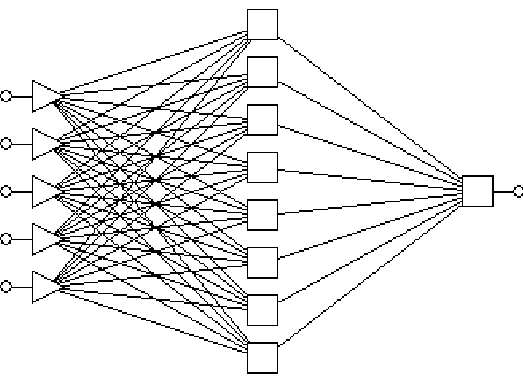
Figure 23. Multilayer ANN 5:5-8-1:1.